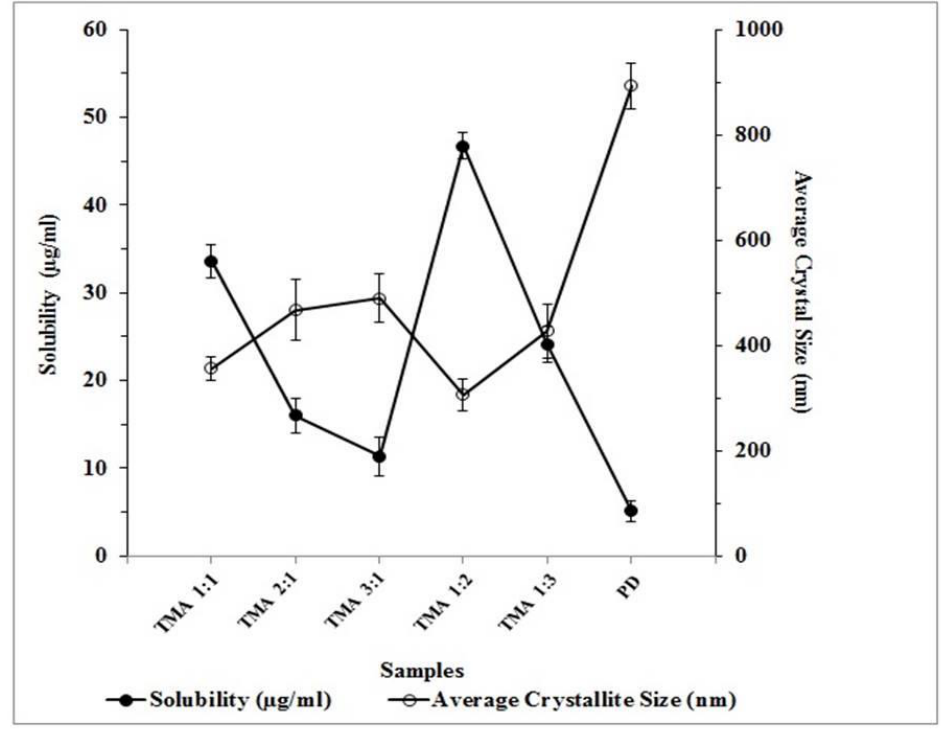
Figure 11. Relationship between crystal size and solubility of telmisartan (PD) and prepared telmisartan-maleic acid cocrystals.